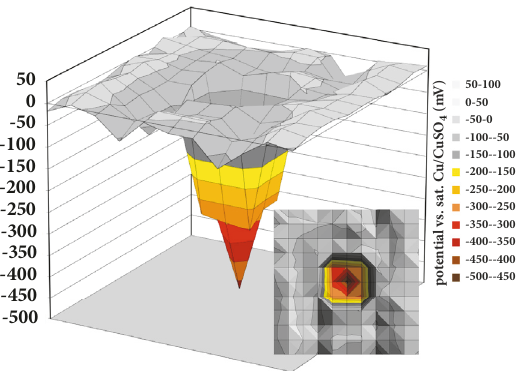
Figure 2: 3D representation of a potential